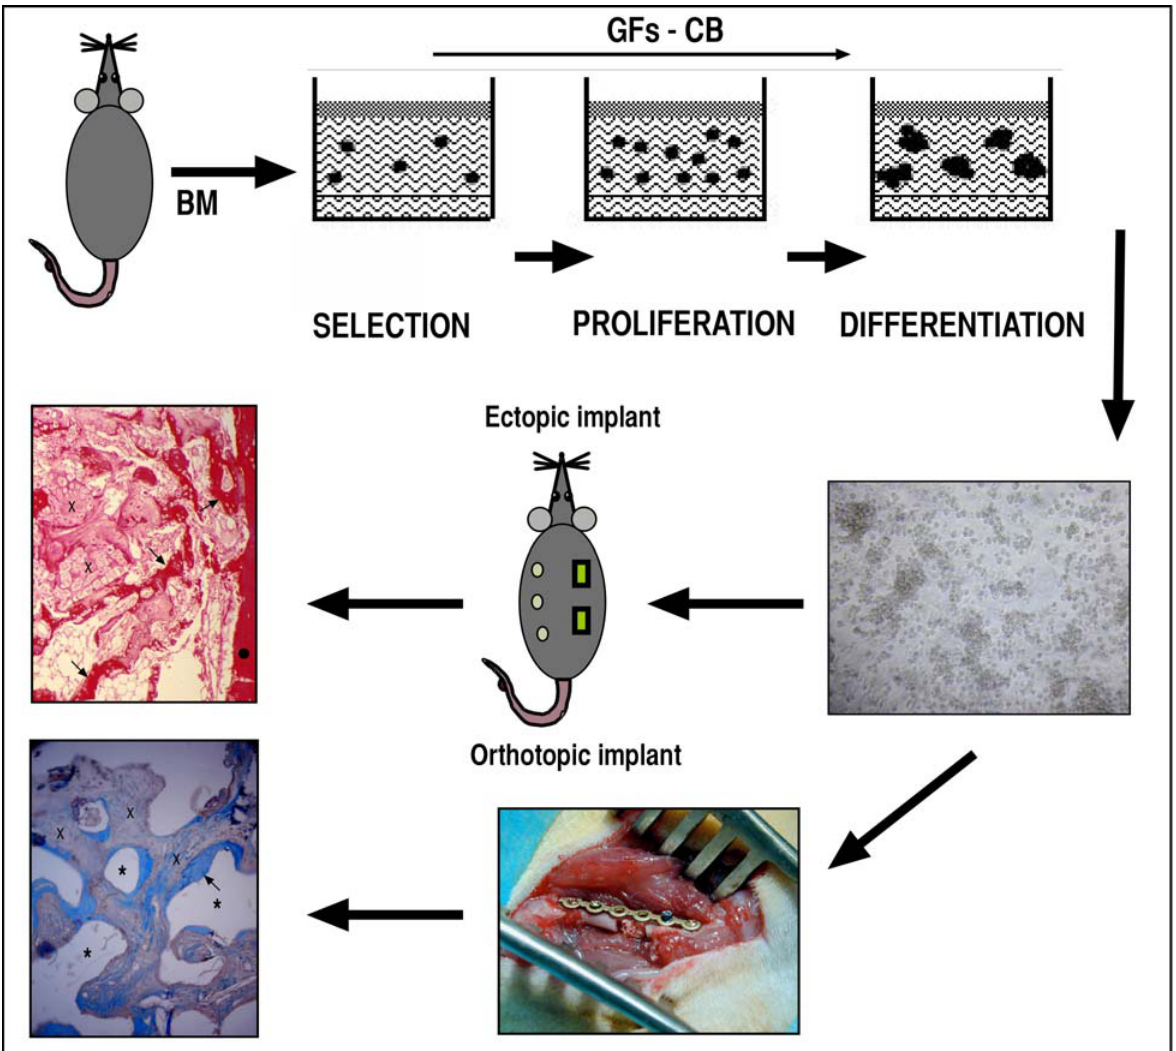
FIGURE 2 . Culture of bone marrow cells for in vivo implantation. Bone marrow cells from rats are cultured in three-dimensional collagen during a short period of time in the presence of 0.5% FBS. After this starvation period, a cell population can be selected. These cells cultured in the presence of 10% FBS proliferate significantly increasing the cell population. Dexamethasone, β -glycerolphosphate, and ascorbic acid are added to induce osteogenic differentiation. All this process can be modulated by TGF β 1 and different BMPs. Cells extracted from the final culture may be ectopically grafted in a DBM chamber. After several weeks, implanted cells produce cartilage and bone inside the chamber. Alternatively, cells from in vitro culture can be orthotopically grafted using hydroxyapatite (HA) as biomaterial. After several weeks, a new tissue occupies the center of the HA. In this new tissue, both cartilage and bone can be easily identified. Arrows (bone tissue), X (cartilage tissue), dots (DBM wall), asterisk (trabeculae of